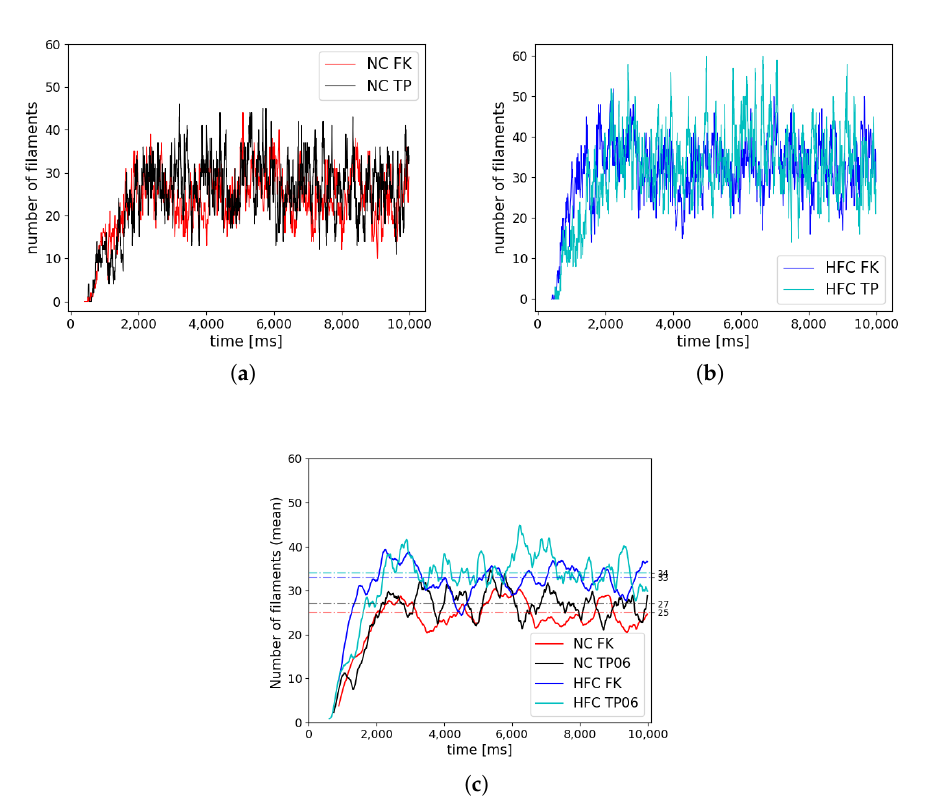
Figure 6. ( a ) Number of filaments for the NC heart, ( b ) number of filaments for the HFC heart, and ( c ) rolling mean for the FK and TP06 models during 10s of sustained VF. Mean values are depicted with dashed lines in panel ( b ) after 2.5s.